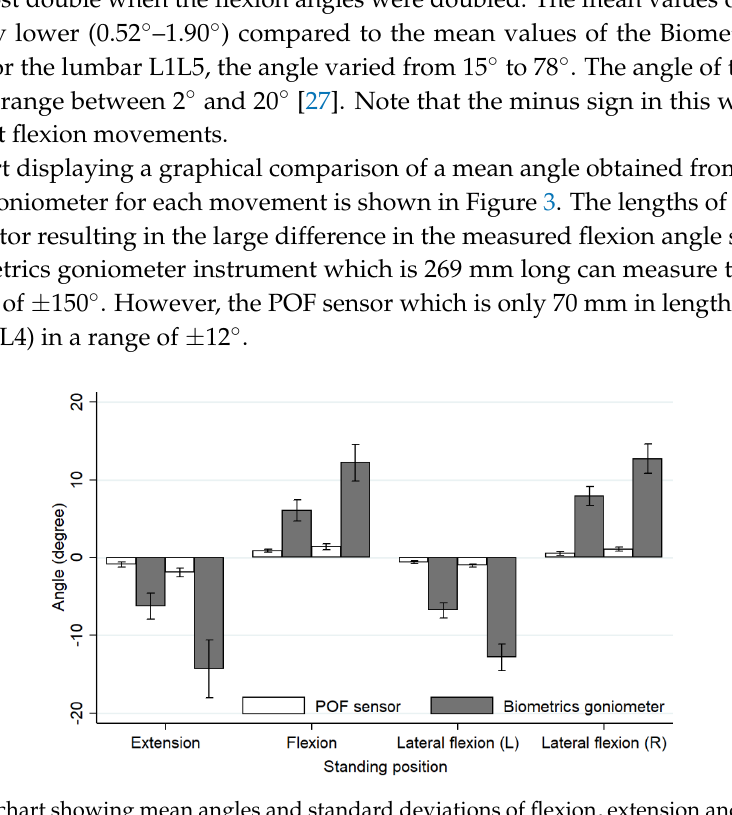
Figure 3. Bar chart showing mean angles and standard deviations of flexion, extension and lateral bend of both directions for the POF sensor (white bar chart) and Biometrics goniometer (grey bar chart).